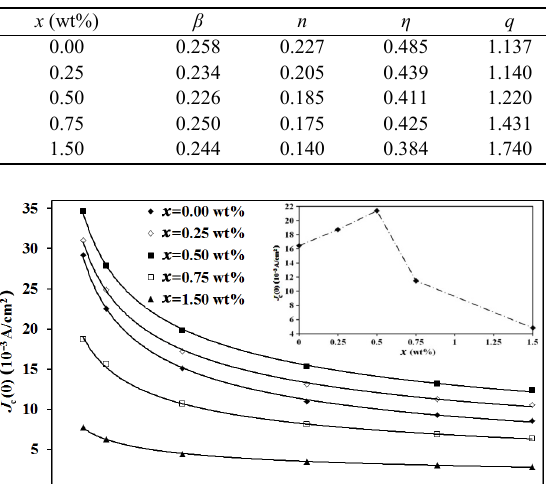
Table 2 Variation of β , n , η , and q versus x for (BaSnO 3 ) x /BiPb-2223 samples